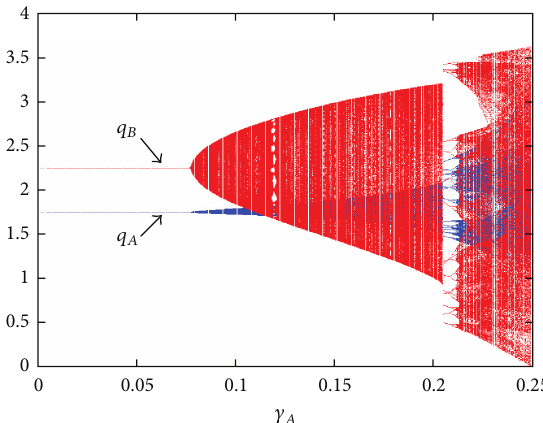
Figure 1: Bifurcation diagram for the quantities 𝑞 𝐴 and 𝑞 𝐵 with the adjustment speed 𝛾 𝐴 .